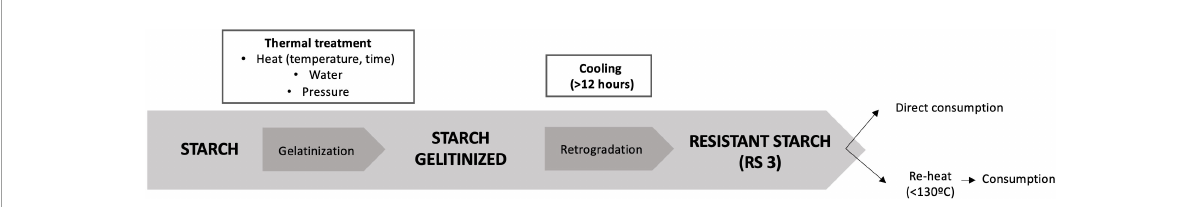
FIGURE1 Resistant starch formation. When applying heat treatment, or cooking to a food rich in starch, it becomes gelatinized. If it is subsequently cooled for a minimum of 12 h, it will retrograde, thus obtaining type 3 resistant starch. The food can be consumed directly or reheated to a temperature of < 130 ◦ C, preventing it from turning back into the non-resistant structure.